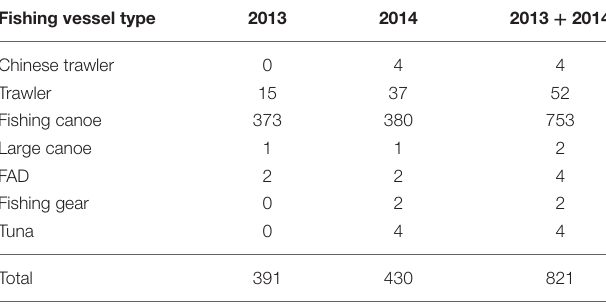
TABLE 2 | Summary of fishing vessels for the 2 survey years and pooled (2013 + 2014). Fishing vessel